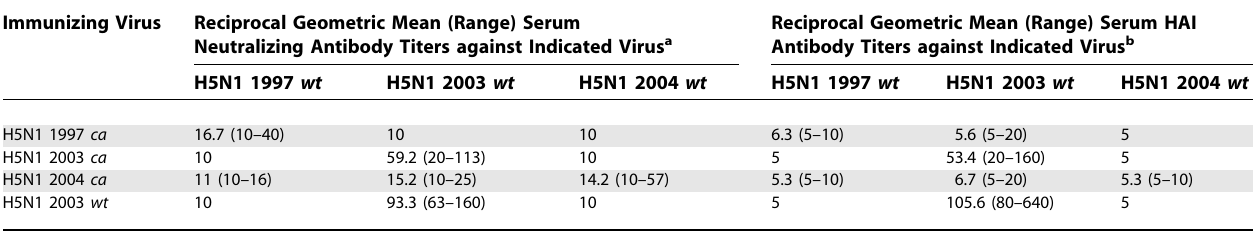
Table 5. Serum Neutralizing and HAI Antibodies Elicited in Mice Following a Single Intranasal Dose of H5N1 ca Vaccine Immunizing Virus Reciprocal Geometric Mean (Range) Serum Reciprocal Geometric Mean (Range) Serum HAI Neutralizing Antibody Titers against Indicated Virus a Antibody Titers against Indicated Virus